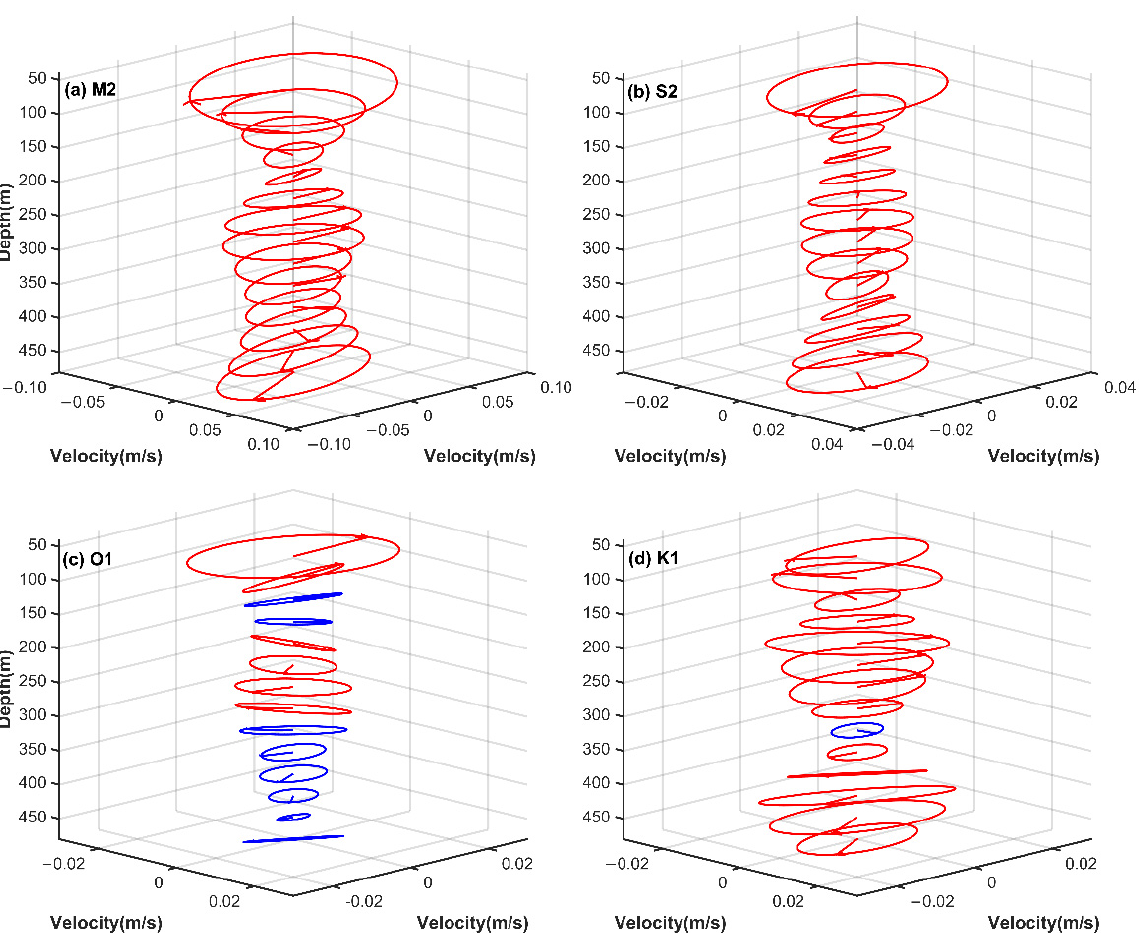
Figure 3. Tidal current ellipses of the major baroclinic tidal constituents obtained from the harmonic analysis. Figure ( a – d ) denote the M 2 , S 2 , O 1 and K 1 tidal constituent, respectively. The red ellipses denote clockwise rotation, and the blue ellipses denote counterclockwise rotation.